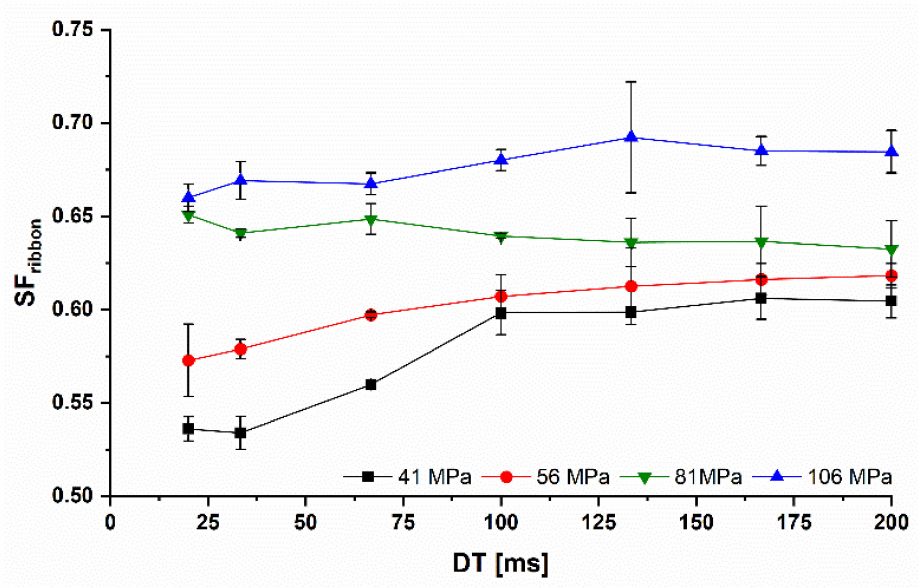
Figure 7. Dwell time dependent SF of MCC ribbons at different P max from 41 to 106 MPa; x ± s ; n = 3. Similar to MCC , the SF ribbon of lactose ribbons increased as expected with higher P max .